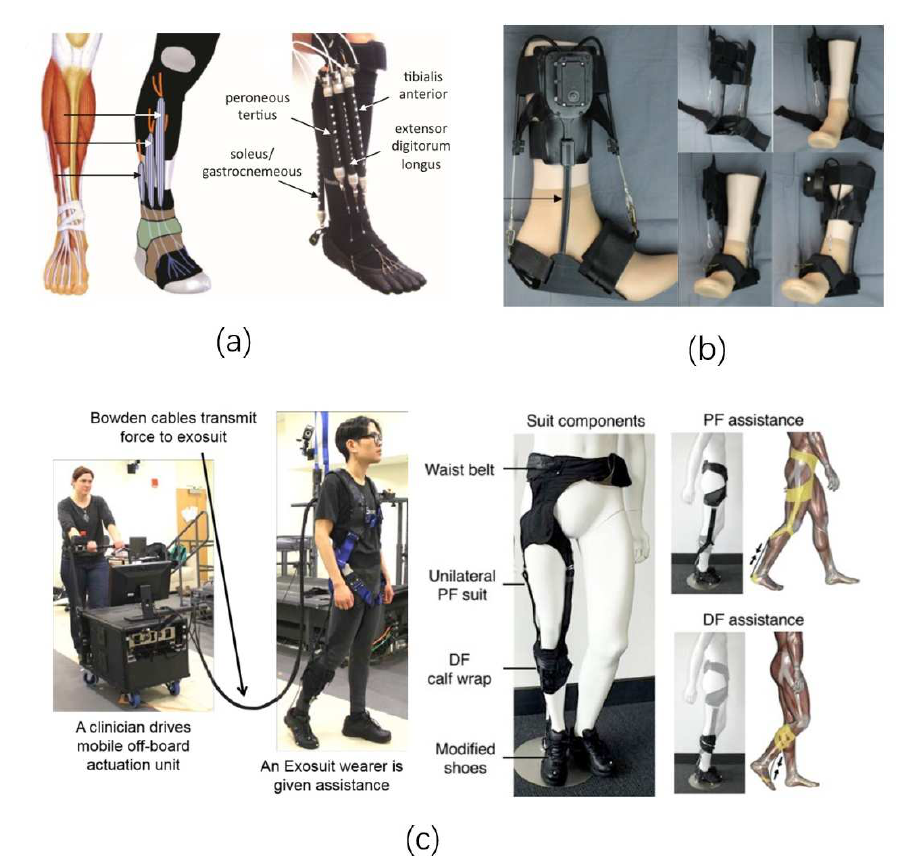
Figure 2. Soft rehabilitation and nursing-care robots based on tendon-driven in lower limb. ( a ) is reprinted from [35]. ( b ) is reprinted from [37]. ( c ) is reprinted from